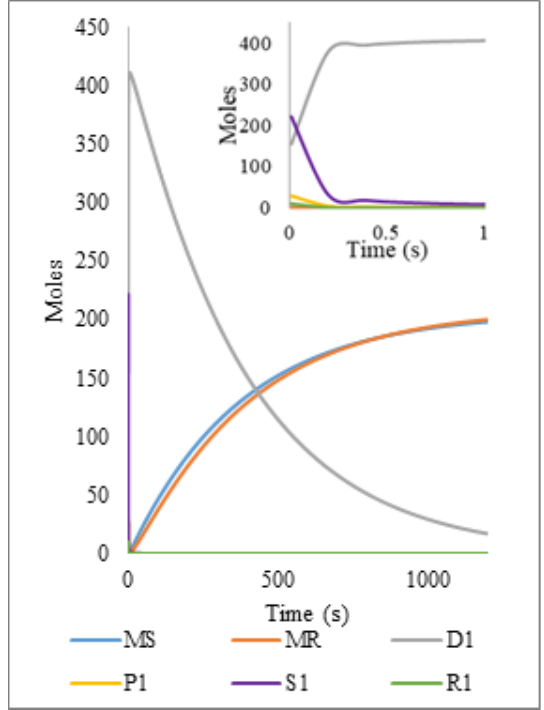
Figure 11. Simulation of reaction dynamics for the pyrolysis of NMP-PS (N/I = 1.3); time variation of MS (styrene monomer), MR (monomeric radical), D1 (first moment of dead polymer), S1(first moment of dormant polymer), R1(first moment of living polymer with nitroxide) and NX (nitroxide radicals). Model predictions at 390 °C and reaction formulation as in Table 2.